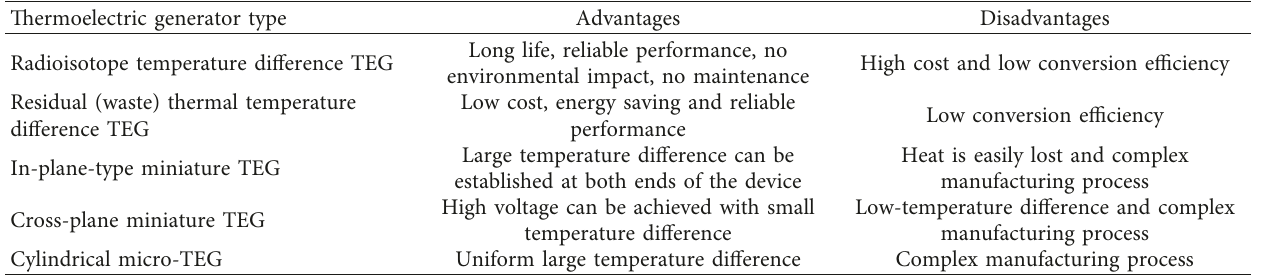
Table 5: Comparison of properties of different thermoelectric generators.